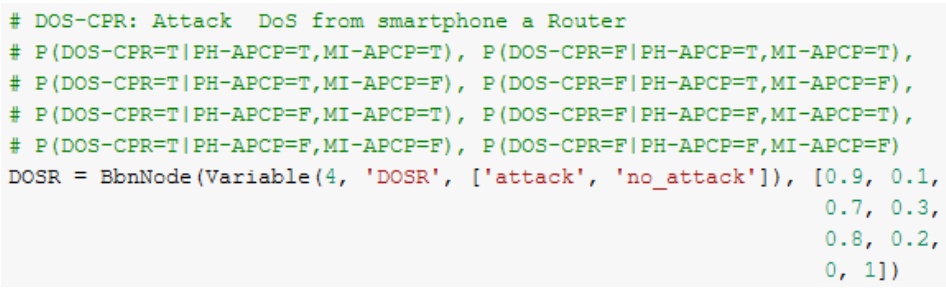
Figure 12. Probabilities of simulated environment of smart home attacks.